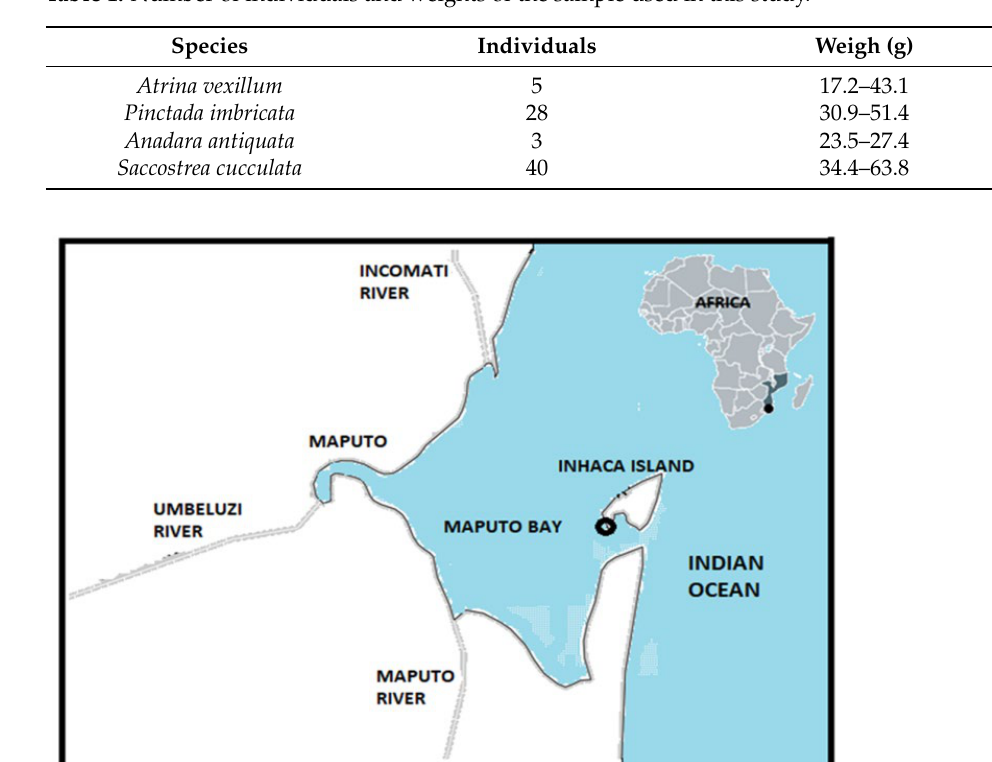
Figure 2. Map of Maputo Bay, Mozambique. Black circle indicates the location site in the Inhaca Is-